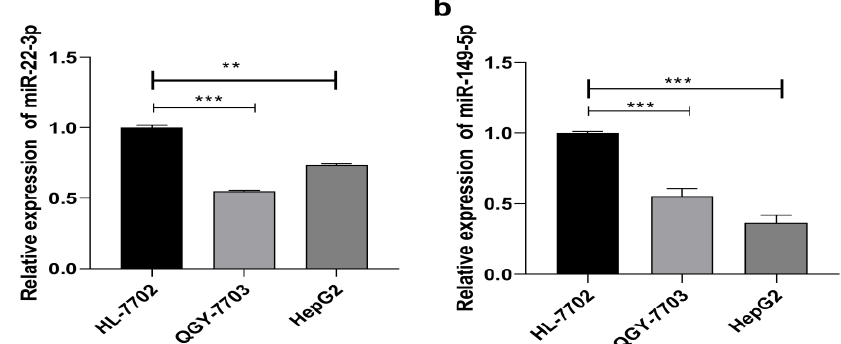
Figure 1. Expression of miR-22-3p in HCC cell lines and in normal liver cells. ( a ) Relative miR-22-3p level in HCC cells and in normal liver cells; ( b ) relative miR-149-5p level in HCC cells and in normal liver cells. ( n = 3, ** p < 0.01, *** p < 0.001).